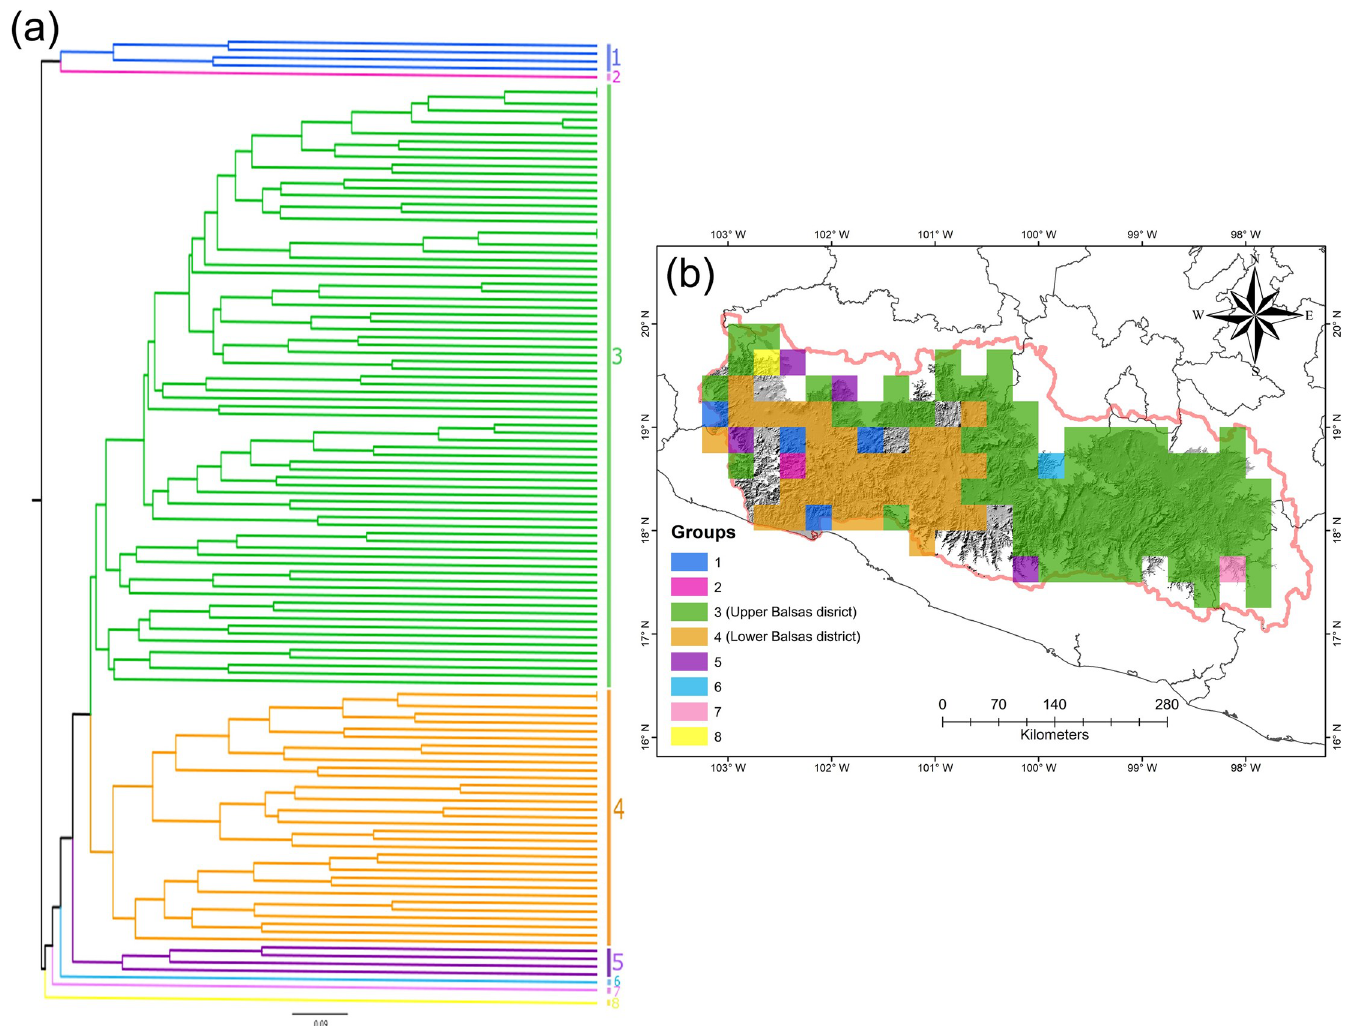
Fig 3. Cluster analysis ( β -Simpson dissimilarity coefficient) showing the floristic dissimilarity of the grid squares with the Asteraceae species from the seasonally dry tropical forest in the Balsas Depression, Mexico. (a) Dendrogram showing floristic dissimilarity. (b) Balsas Depression where the colors correspond to the groups shown in the